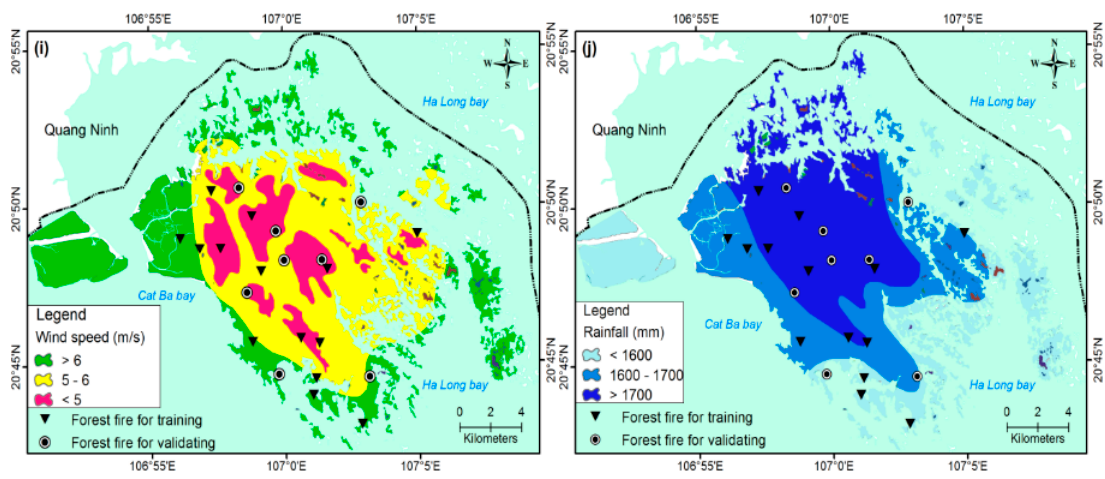
Figure 2. Forest fire variables: ( a ) slope; ( b ) aspect; ( c ) TWI ( Topographic Wetness Index ); ( d ) distance to road; ( e ) distance to populated areas; ( f ) land cover; ( g ) NDVI; ( h ) surface temperature; ( i ) wind speed; ( j ) rainfall.